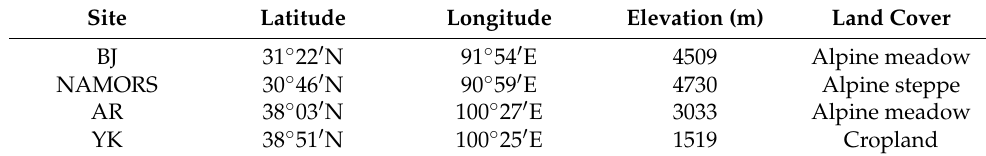
Table 2. Basic information about the verification